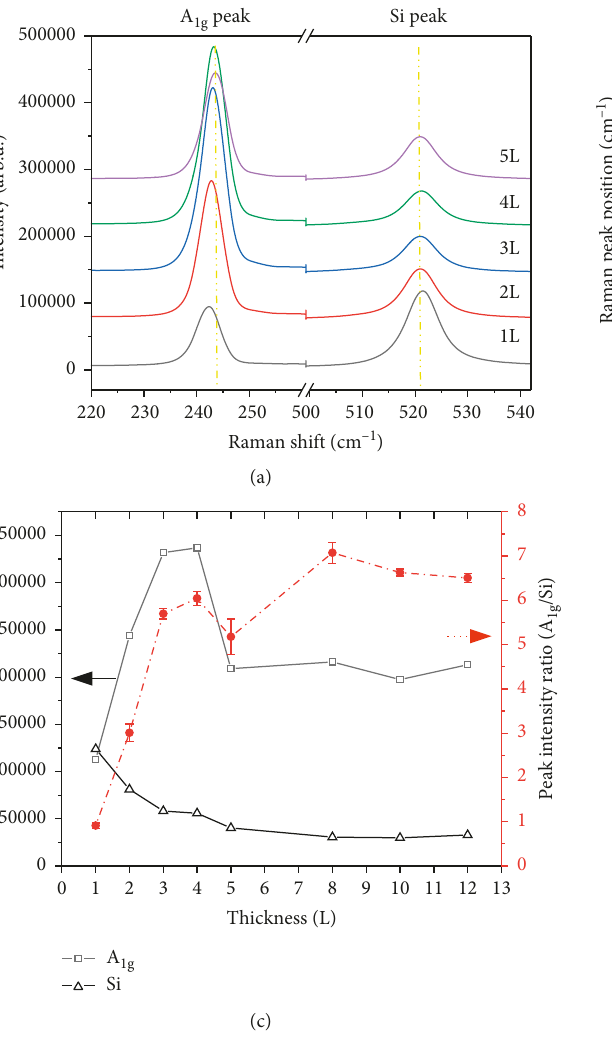
(Figure 4(a)) of MoSe 2 and WSe 2 . Laser with a wavelength of